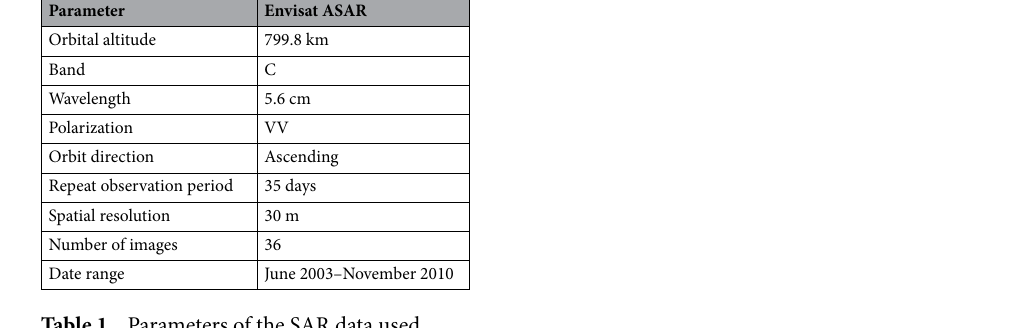
Table 1. Parameters of the SAR data